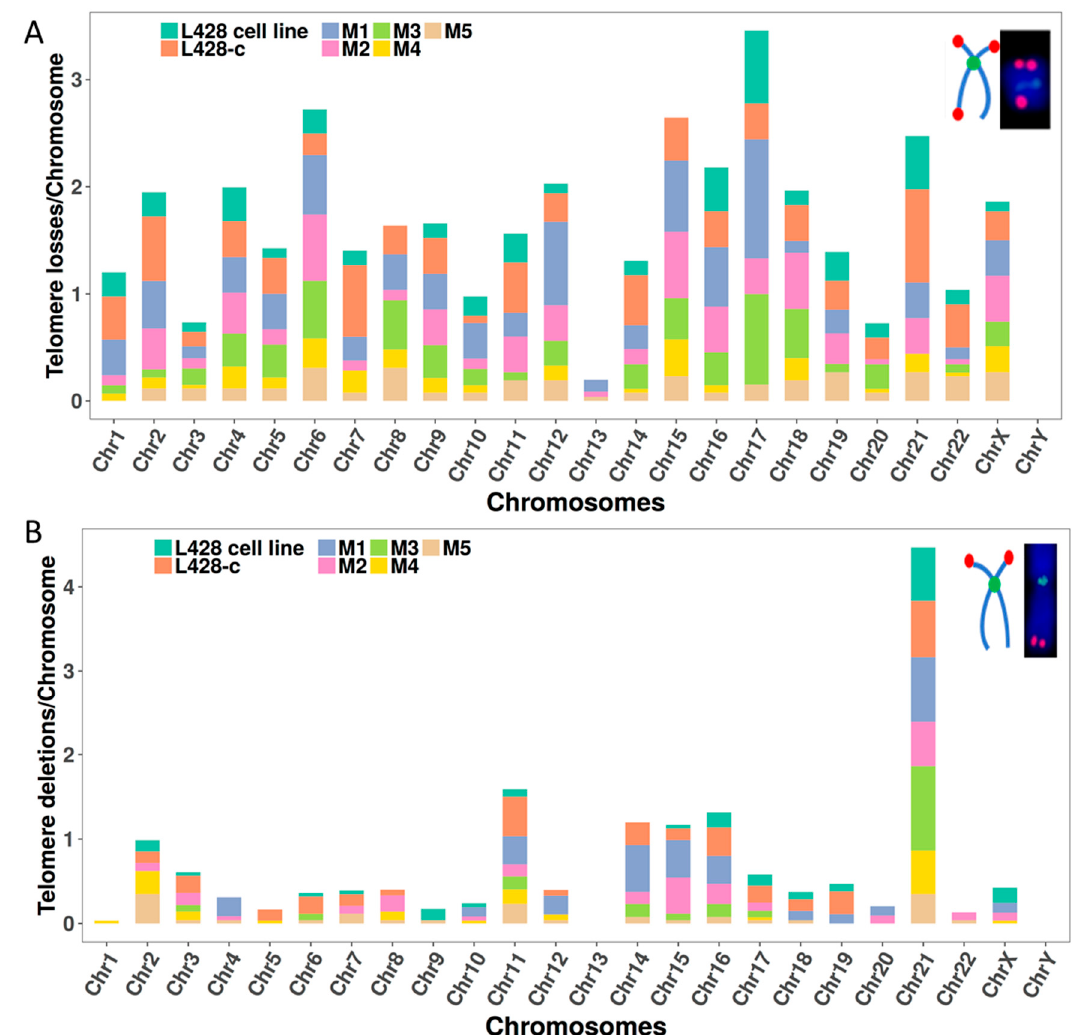
Figure 7. Telomere aberrations in each chromosome in the parental L428 cell line, L428-c subline, and in liver-derived HL cells from five mice (M1–M5). ( A ) Telomere loss and ( B ) Telomere deletion assessed on the basis of telomere and centromere staining followed by M-FISH. For technical reasons telomere aberration analysis was not performed on cells from mouse 6.